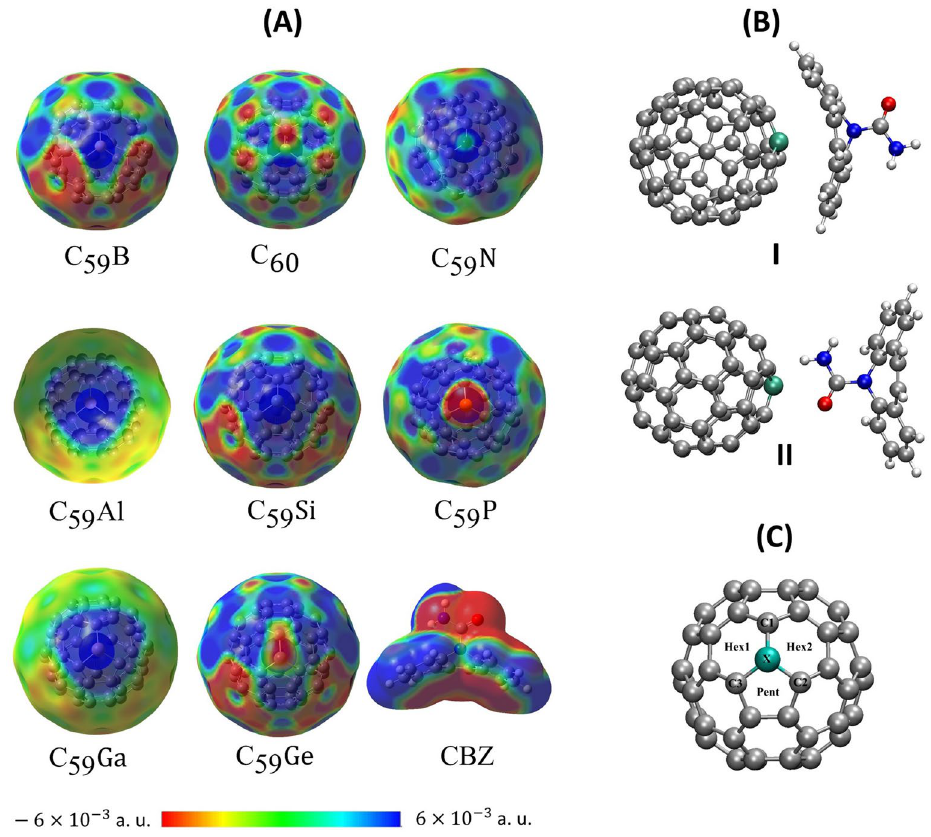
Figure 2. ( A ) C 59 X Molecular Electrostatic Potential in the range of ± 6 × 10 − 3 a. u. ( B ) Initial relative orientations for the C 59 X-CBZ dimers. ( C ) Fontal view of the doping atom X, highlighting the surroundings carbons and hexagonal and pentagonal faces around the